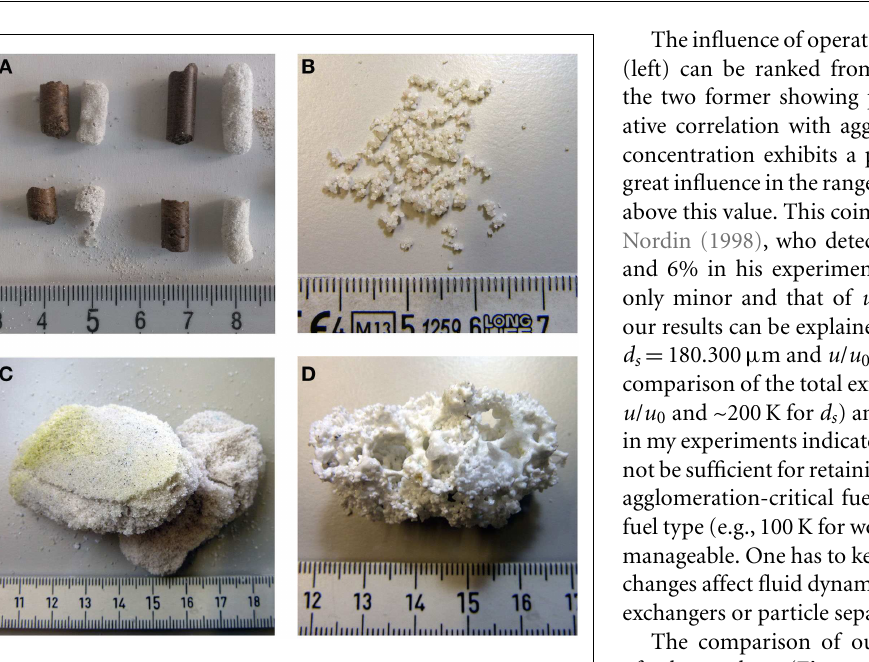
FIGURE 9 | Four types of agglomerates as observed in our experiments: (A) fuel particle shape; (B) oligo-grain; (C) complete sintering; (D) fused structure